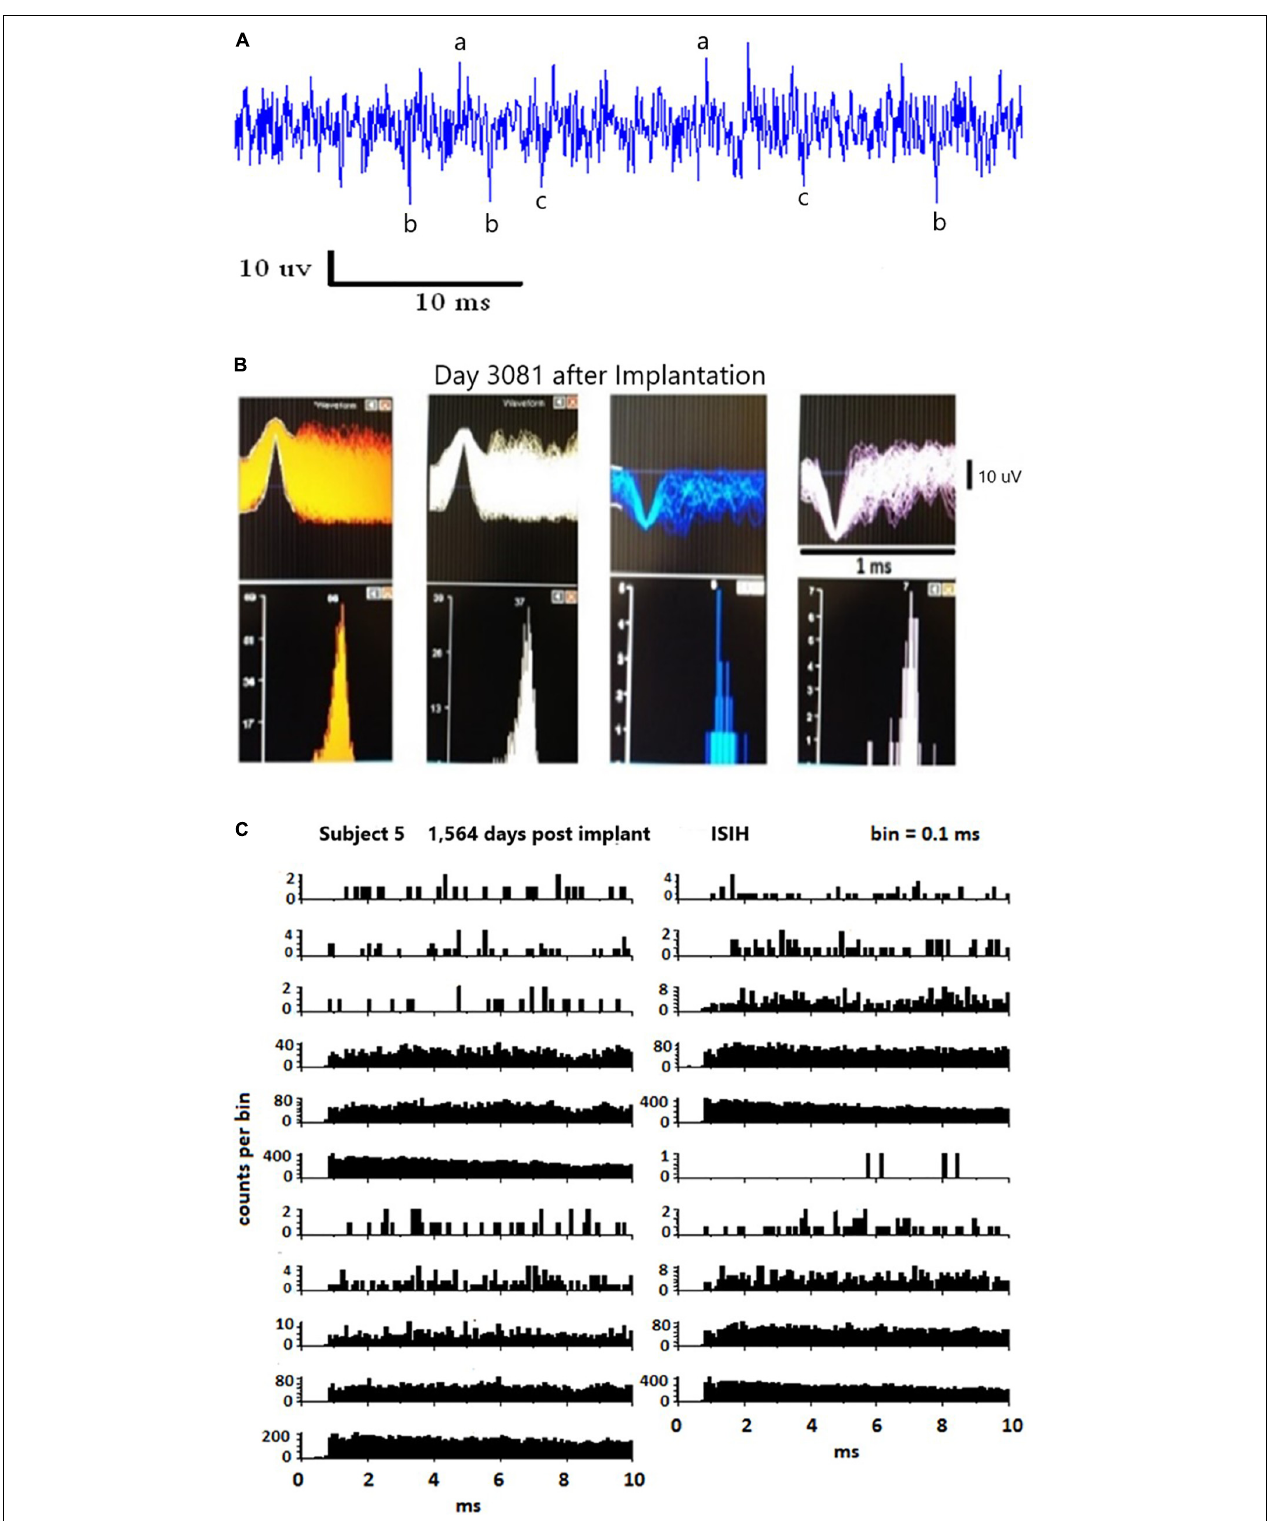
FIGURE 3 | (A) Illustrates a 40 ms continuous data stream. Note the low amplitude of the data. The potential single units are labeled (a,b,c). Discriminating these potential signals from noise using auto-correlograms is illustrated in (B) . Note the single peaks in the autocorrelations. Inter-spike interval histograms five years after implantation are illustrated in (C) . These data are valid only for fast firing units, as shown.